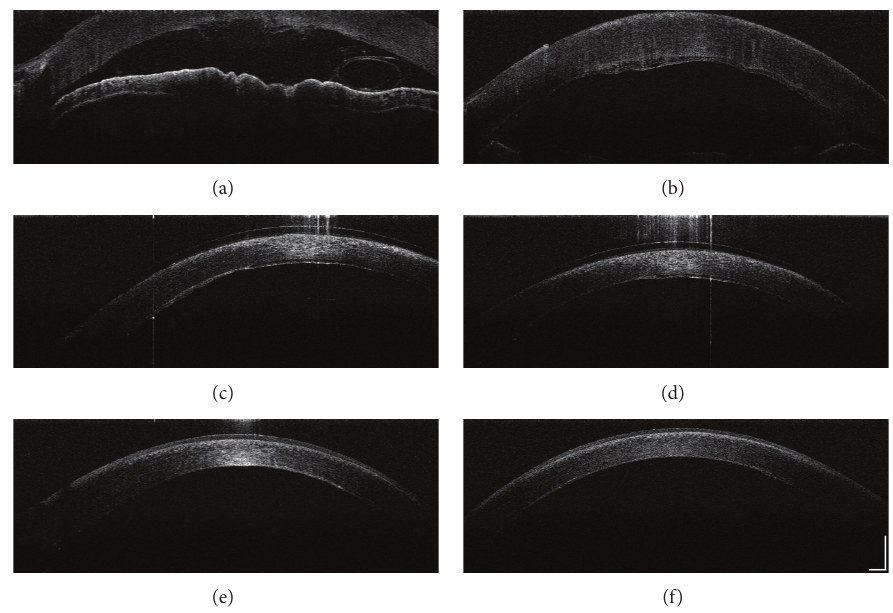
Figure 2: Anterior segment optical coherence tomography (ASOCT) images during and after Descemet membrane endothelial keratoplasty (DMEK). (a) Intraoperative ASOCT demonstrating single scroll configuration of DMEK donor seen in the anterior chamber. (b) Intraoperative ASOCT showing initial adhesion. (c) Two hours after DMEK showing early adhesion of DMEK donor with small amount of interface fluid. (d) One day after DMEK with further adhesion of donor graft. (e) One week after DMEK demonstrating reepithelization and thinning of central cornea. (f) One month after DMEK showing complete DMEK donor adhesion with remodeling of cornea stroma and further reduction in